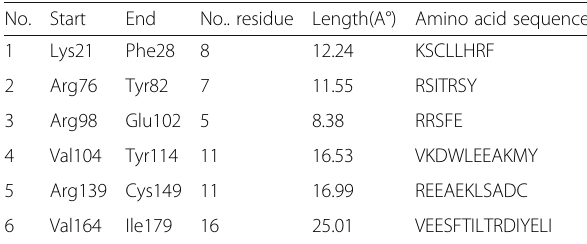
Table 2 Secondary structure details of the Rab39a: the α - helices in Rab39a